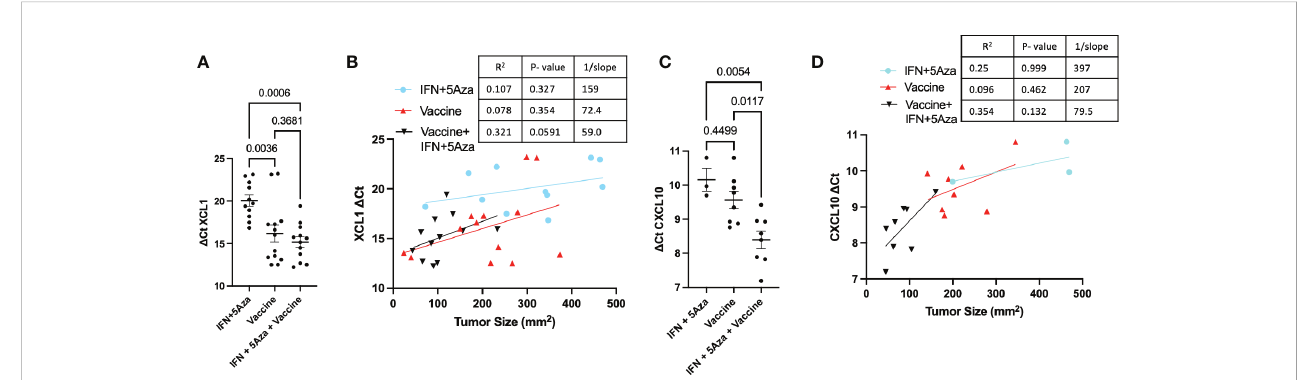
FIGURE 2 Tumor Lysate Chemokine RNA Expression. At harvest, RNA was Extracted from all or a cross-section of tumor and analyzed by qRT-PCR. Values are expressed as D CT normalized to GAPDH expression. (A) Expression of XCL1 across groups and (B) correlated to tumor size. (C) Expression of CXCL10 across groups and (D) correlated to tumor size. All data represent 2-3 independent experiments with sample sizes ranging from 3-5 per group per experiment. Group comparisons were tested by One-Way Anova with Tukey ’ s multiple comparisons test. Correlations analyzed by Spearman correlation coef fi cient